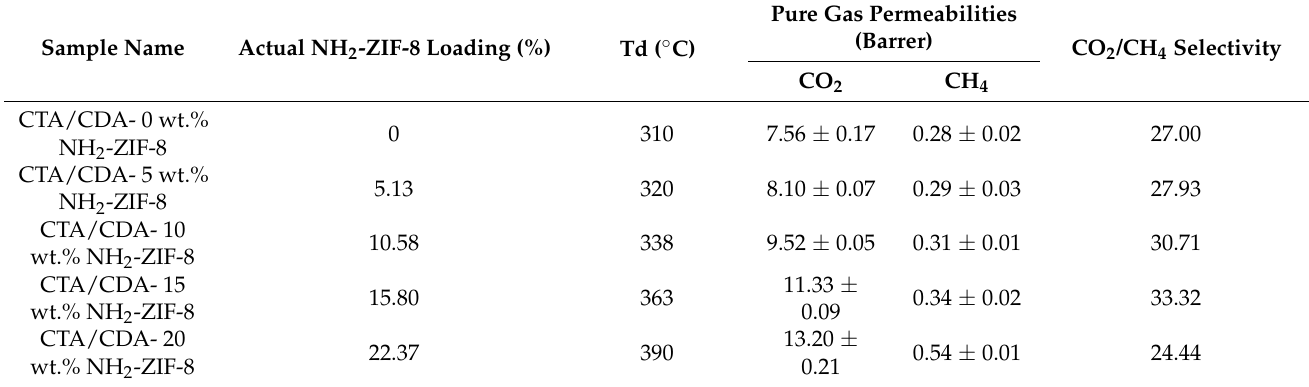
Figure 2. TGA of pure NH 2 -ZIF-8 and CTA/CDA-NH 2 -ZIF-8 MMMs with different NH 2 -ZIF-8 loadings. Table 1. Comparison of pure gas separation performance and decomposition temperature (Td) of CTA/CDA-NH 2 -ZIF-8 MMMs with different NH 2 -ZIF-8 loadings.